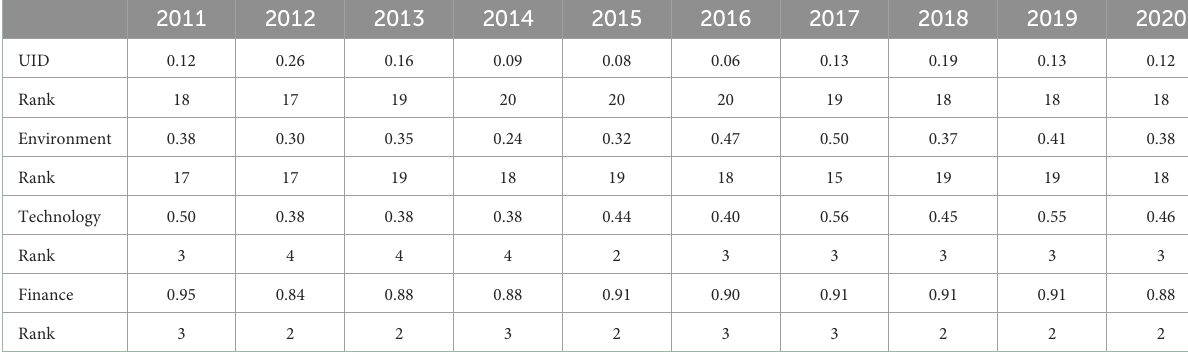
TABLE 3 Development status of various factors in